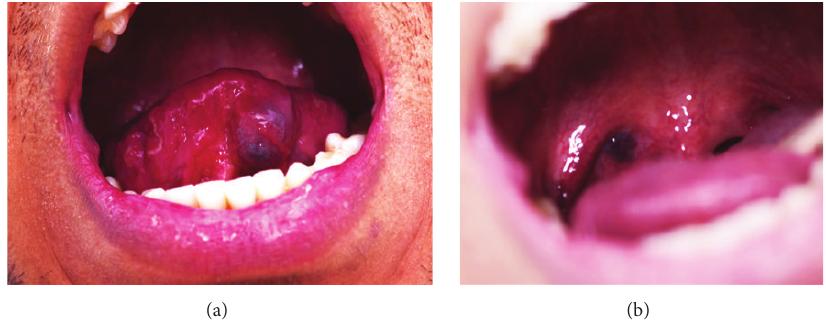
Figure 1: (a) Left ventral tongue lesion. (b) Oropharyngeal lesion located in the right superior tonsillar fossa.